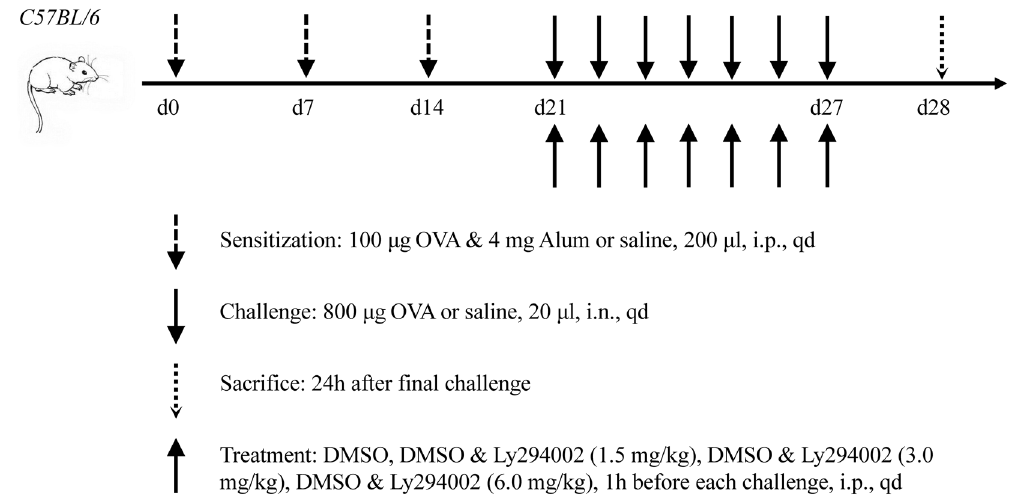
Figure 6. Schematic diagram of the AR model and treatment with Ly294002. i.p . intraperitoneal injection, i.n . intranasal administration, qd quaque